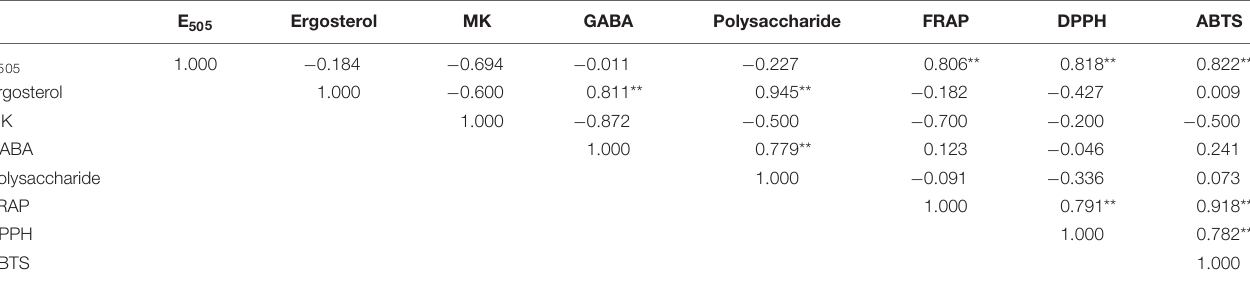
TABLE 3 | Correlation analysis among key active components and antioxidant activities of FQ and